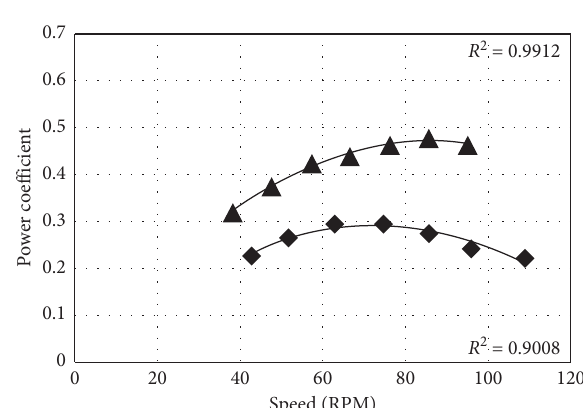
Figure 19: Runner 2 data points.